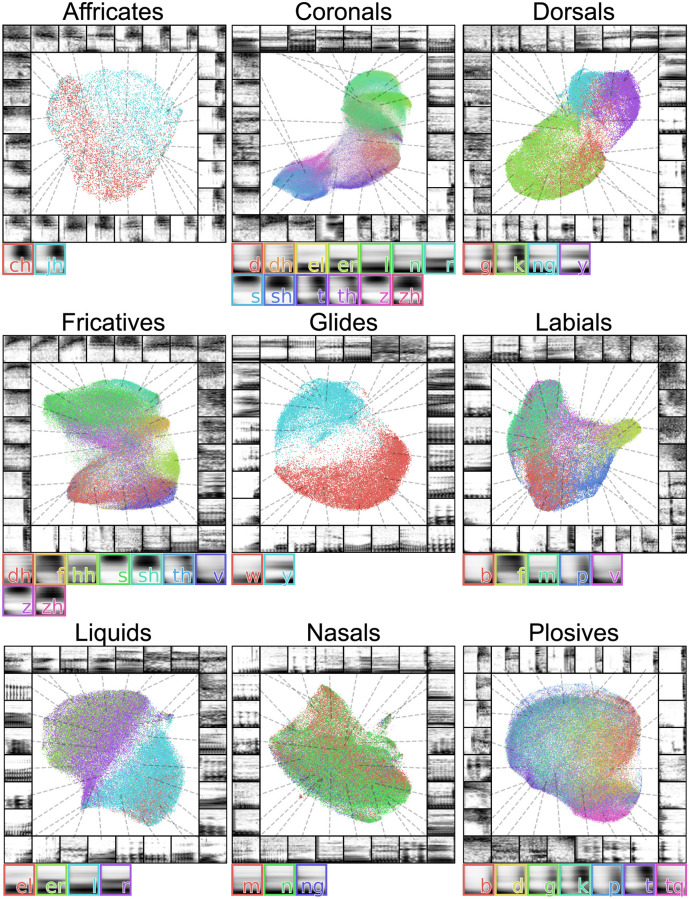
Latent projections of consonants.Each plot shows a different set of consonants grouped by phonetic features. The average spectrogram for each consonant is shown to the right of each plot.